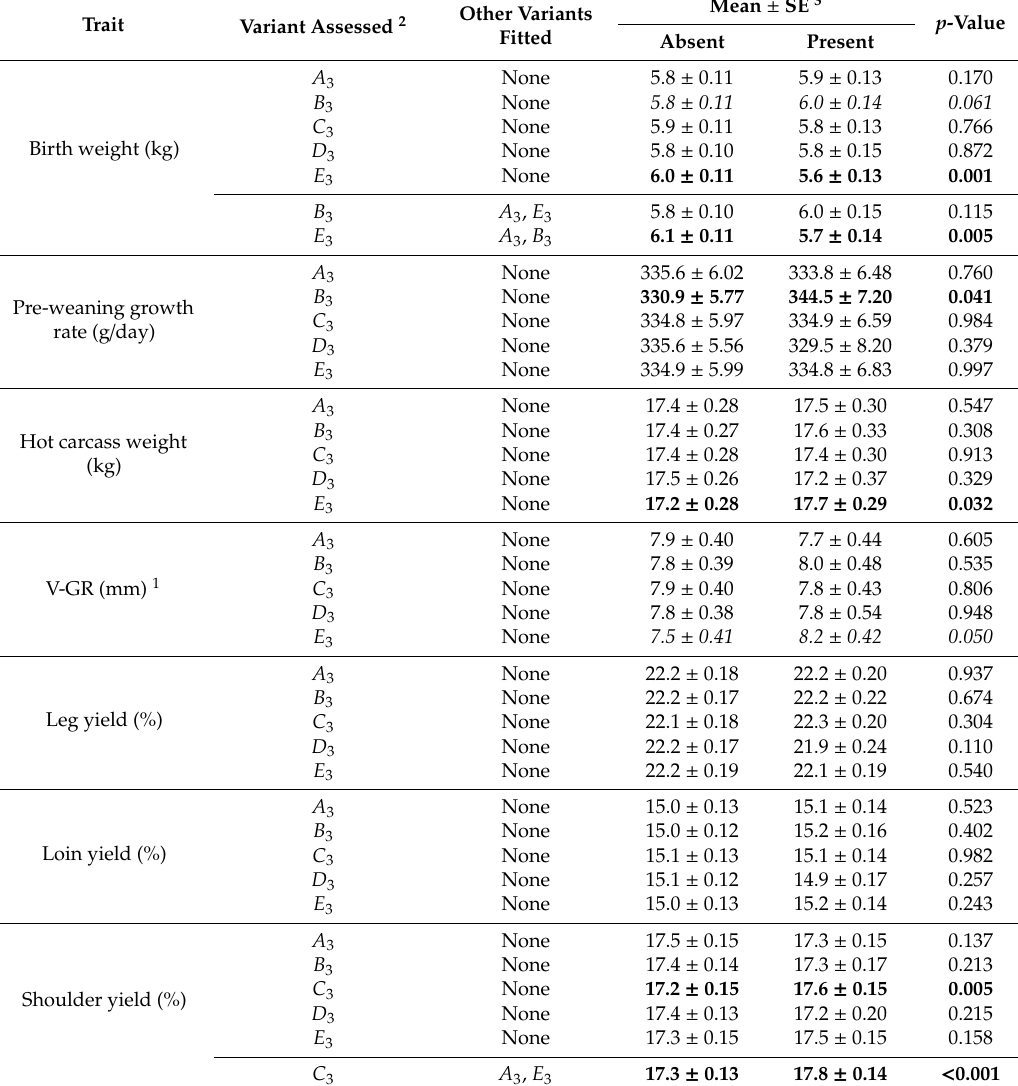
Table 2. Associations between the presence / absence of LIPIN1 variants and variation in selected production